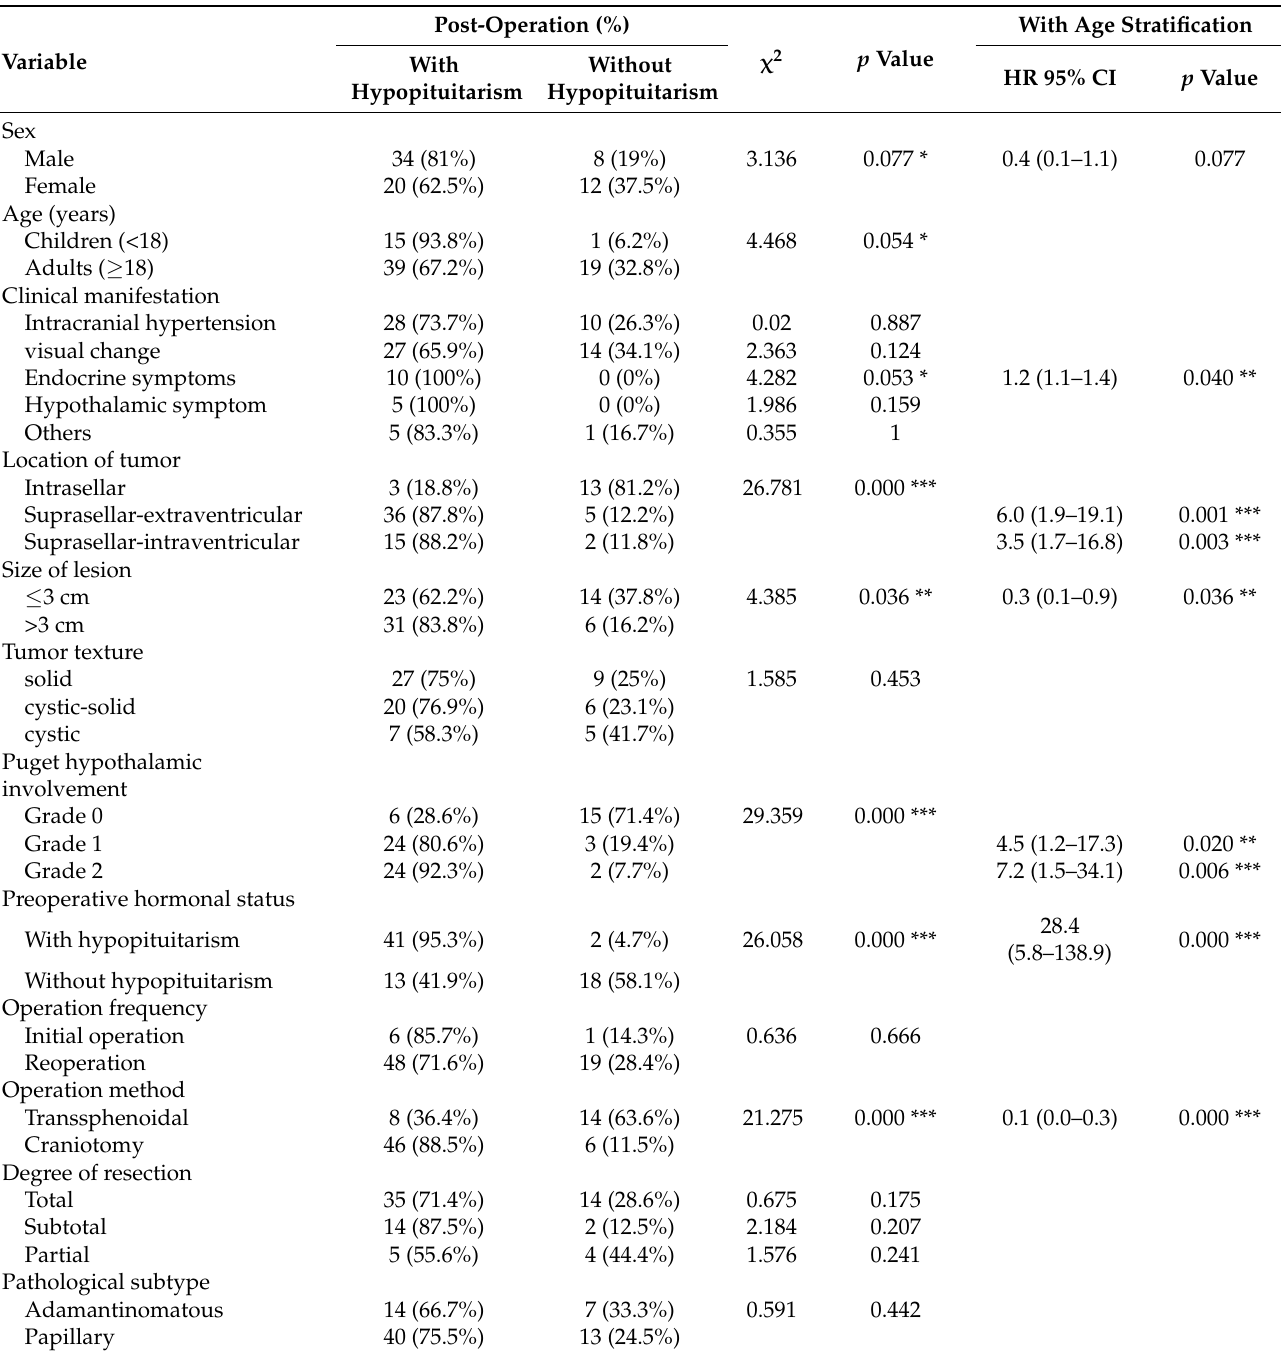
Table 4. Univariate analysis of factors related to postoperative hypopituitarism in 74 craniopharyn- gioma patients with reserved pituitary stalk, age stratification (child and adult at